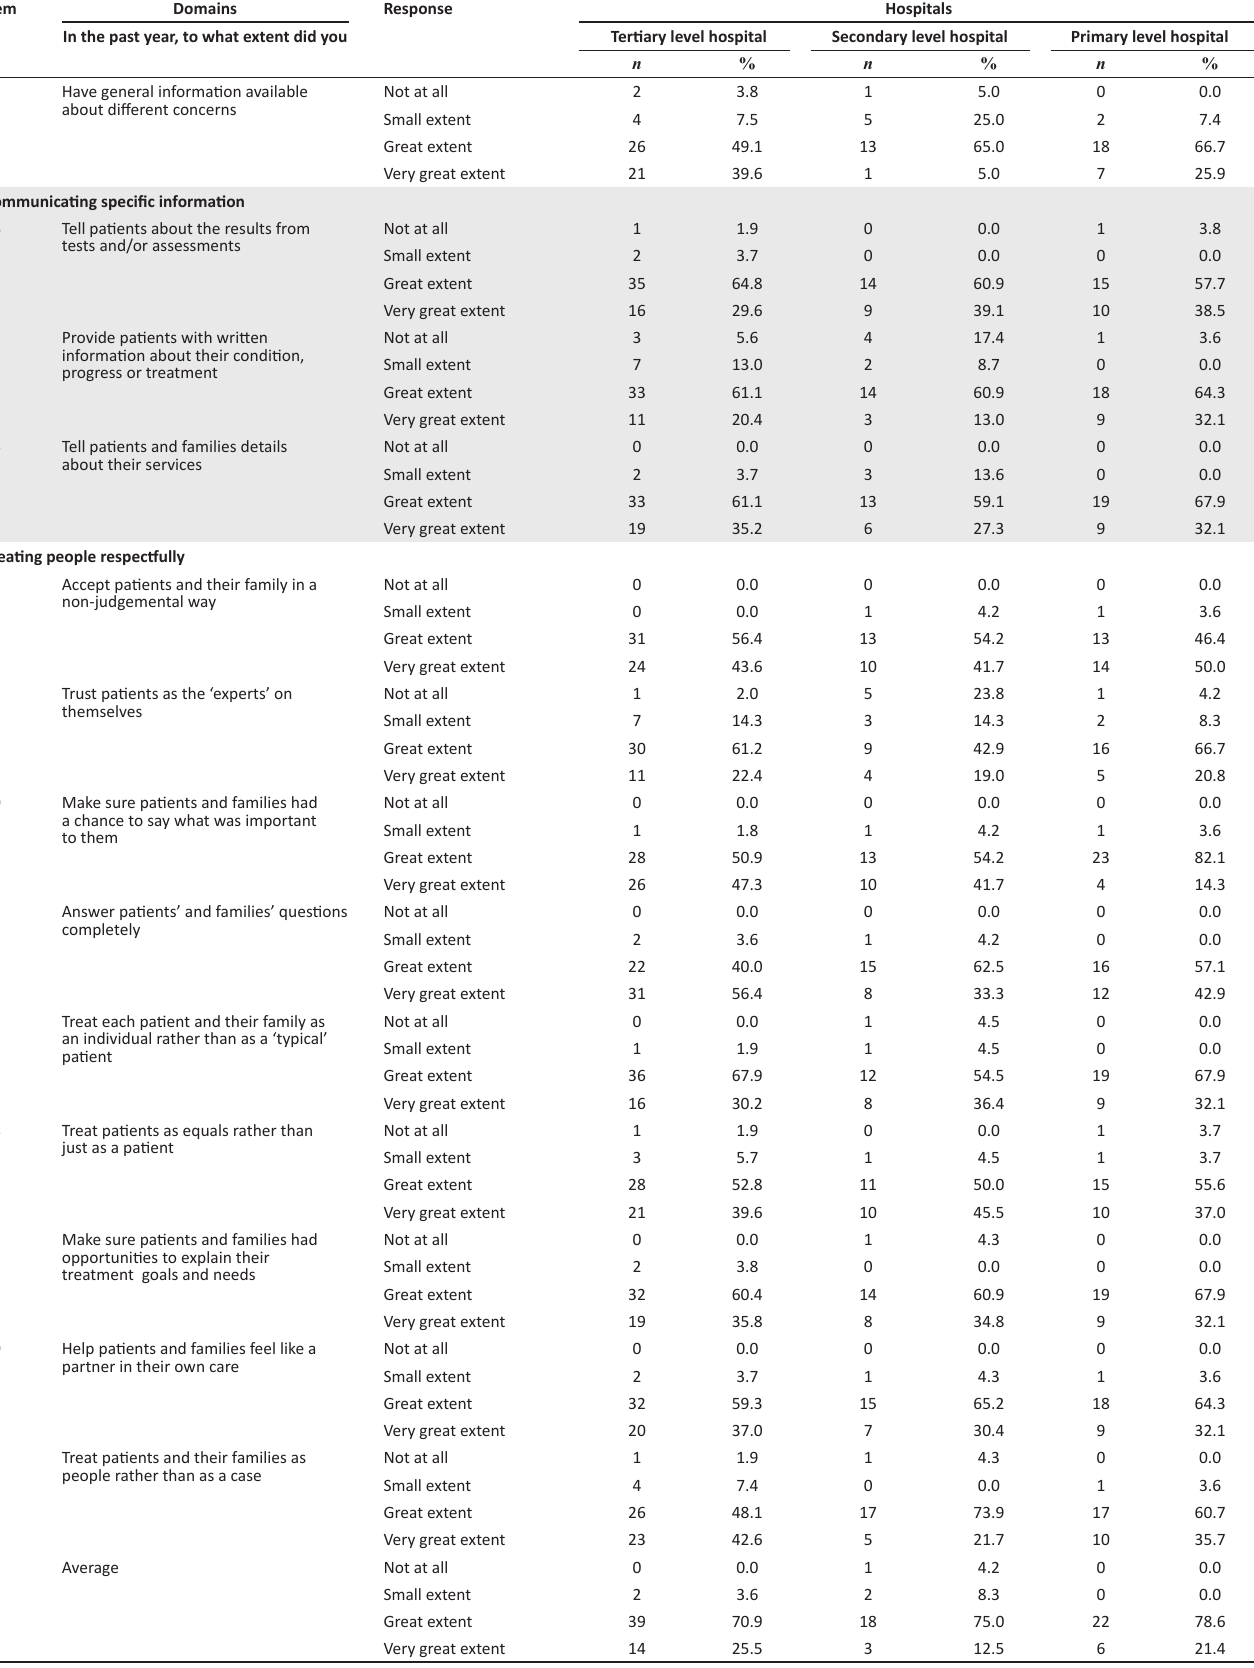
TABLE 1-A1 (Continues...): Patient and family centredness of